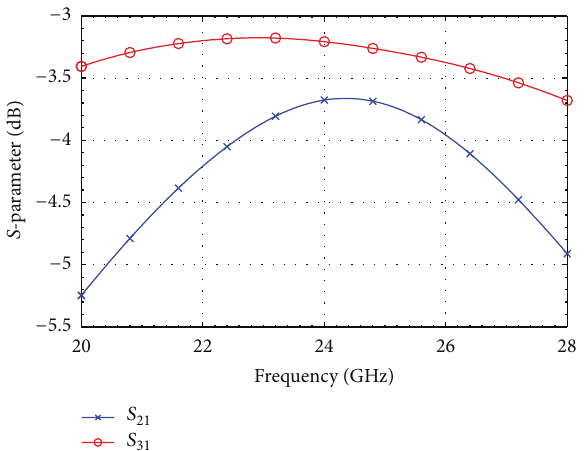
Figure 7: Simulated transmission coefficient of coupler.